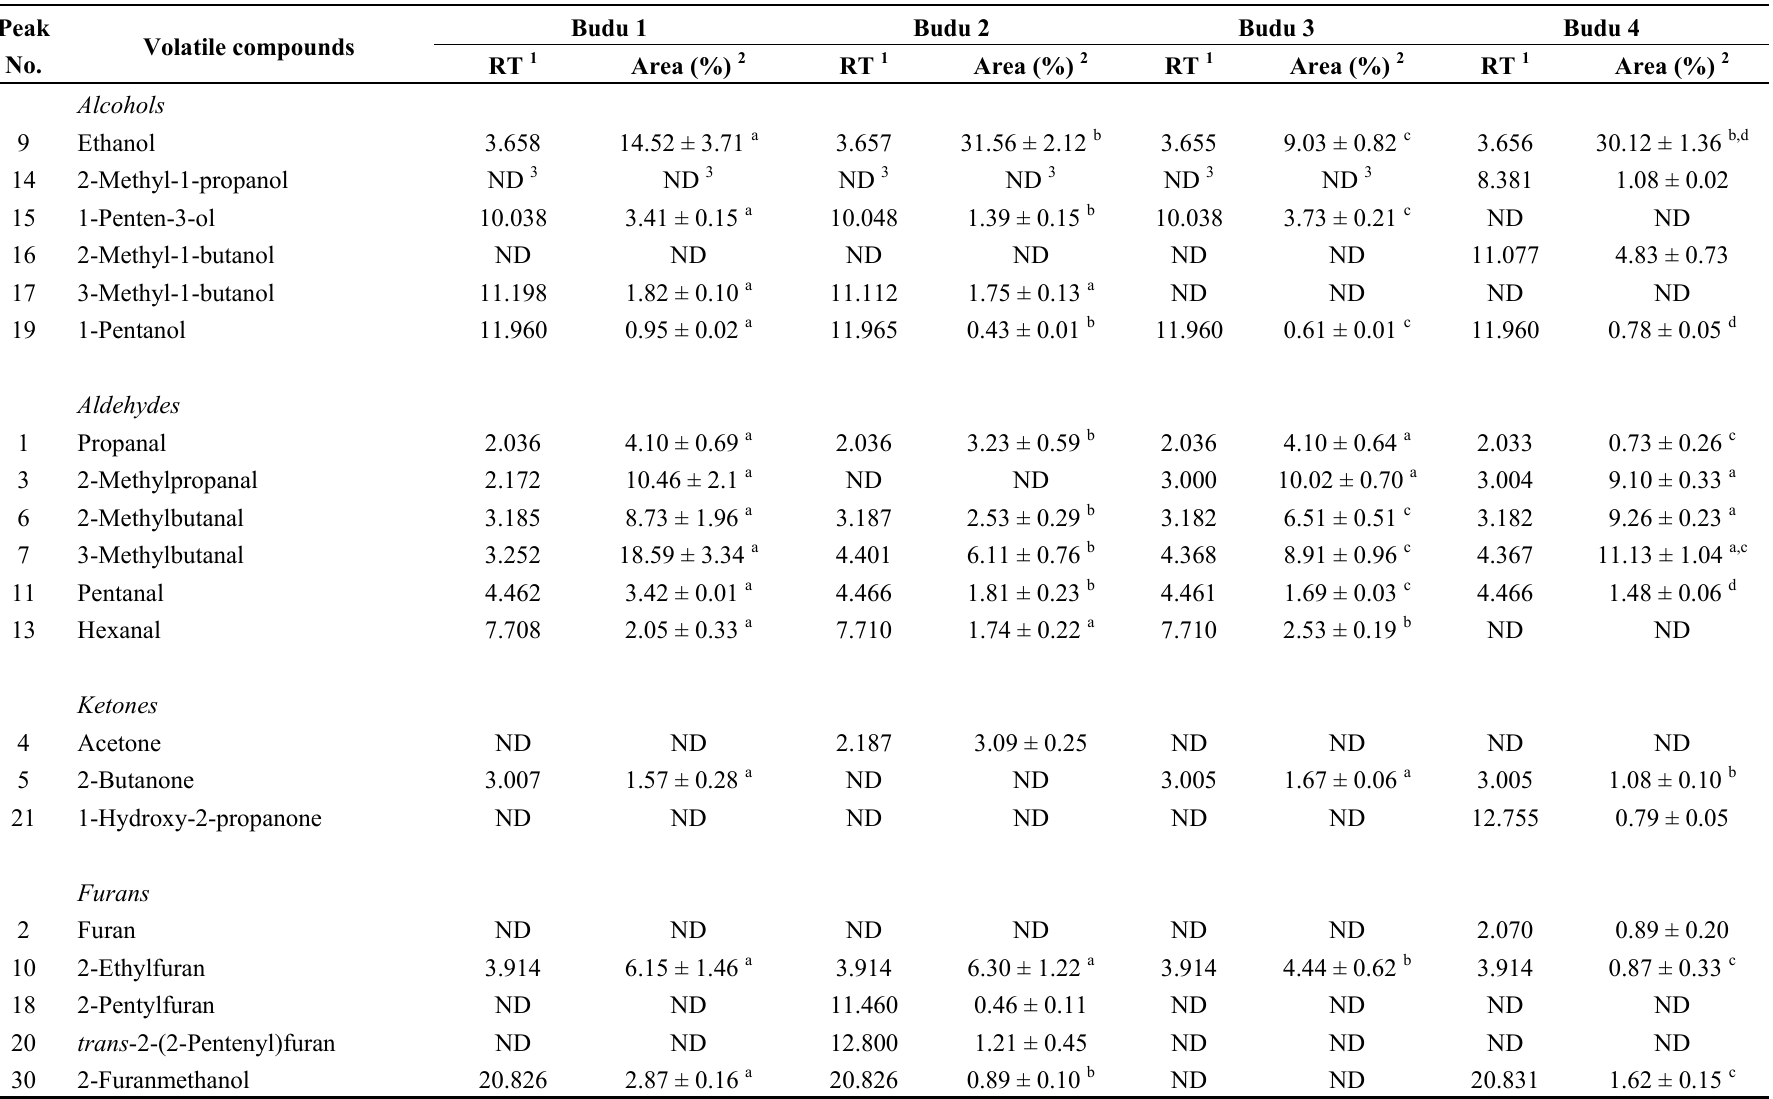
Table 3. Retention time and percentage of area of volatile compounds detected in four Budu samples by using DB-WAX column. Peak